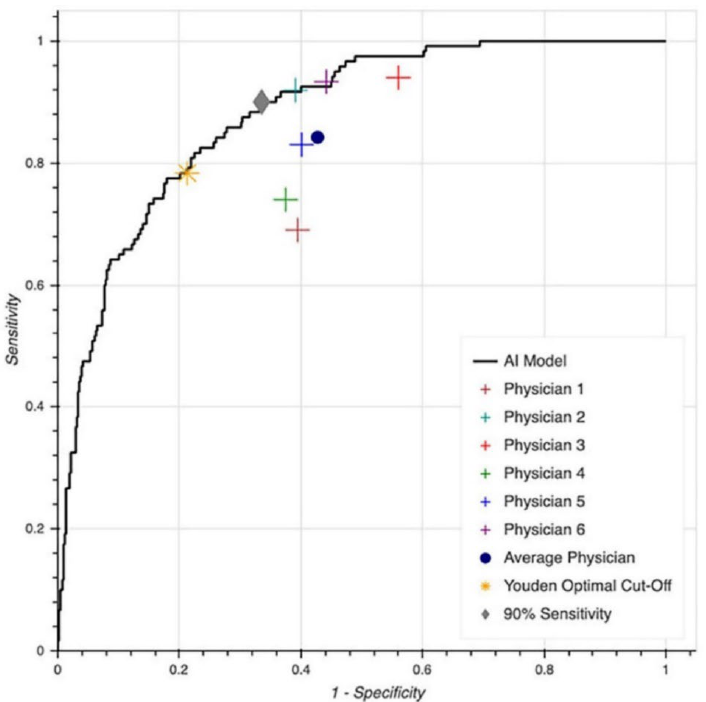
Figure 4. Receiver operating characteristic curve and physician performance in differentiating nor- mal from abnormal ejection-fraction form 12- lead ECG by defining EF ≤ 35% as abnormal (area un- from abnormal ejection-fraction form 12-lead ECG by defining EF ≤ 35% as abnormal (area under der curve = 0.88). curve =